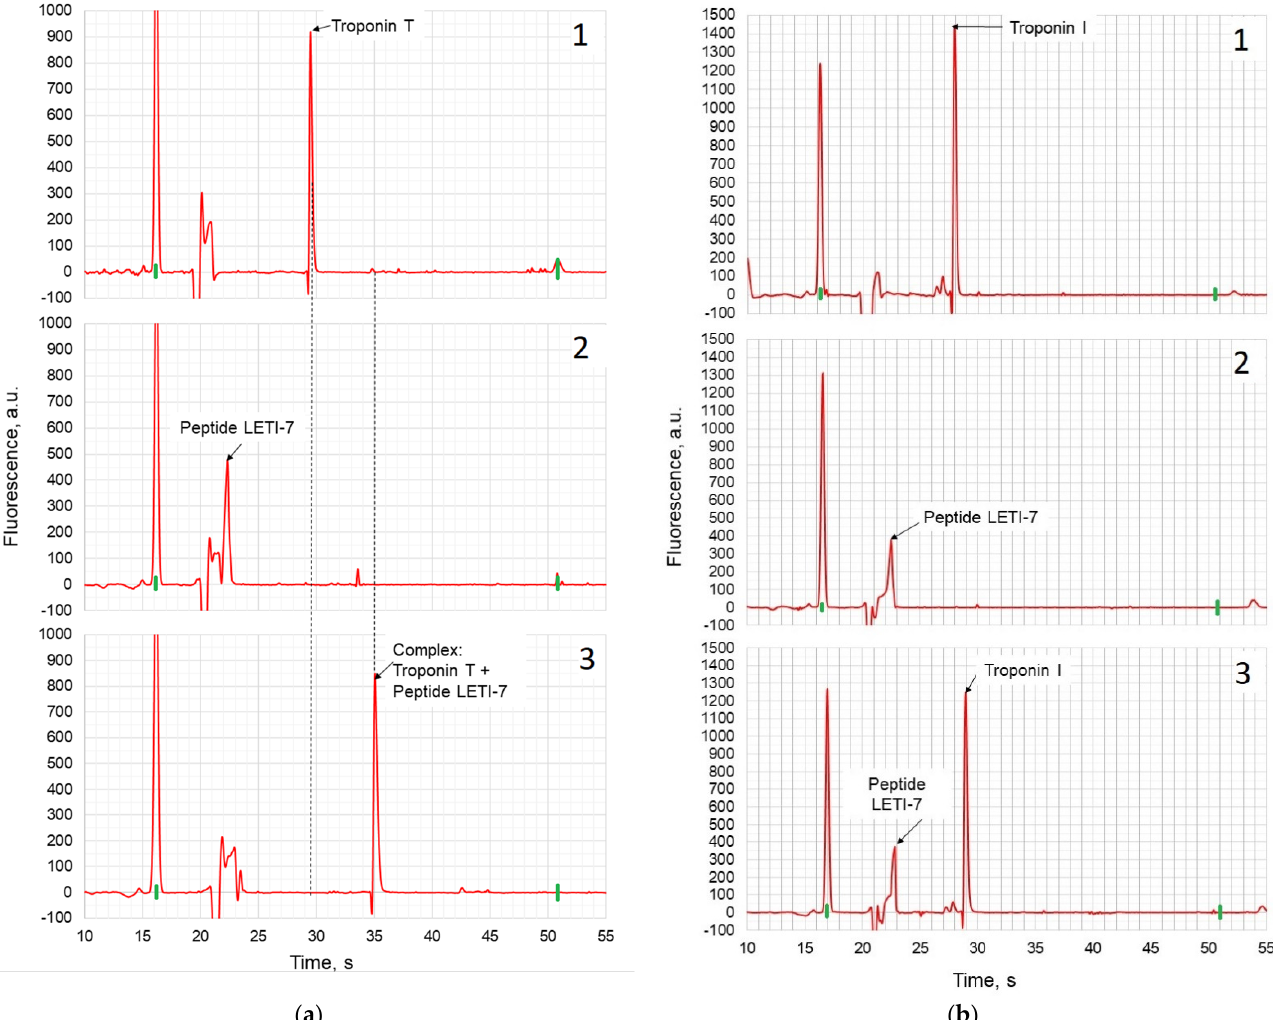
Figure 2. Capillary gel electrophoresis of peptide aptamer LETI-7 with troponin T ( a ) and Troponin I ( b ) using a Bio-Rad Experion station: 1—Protein, 2—Peptide LETI-7, 3—Mixture of peptide LETI-7 and protein.